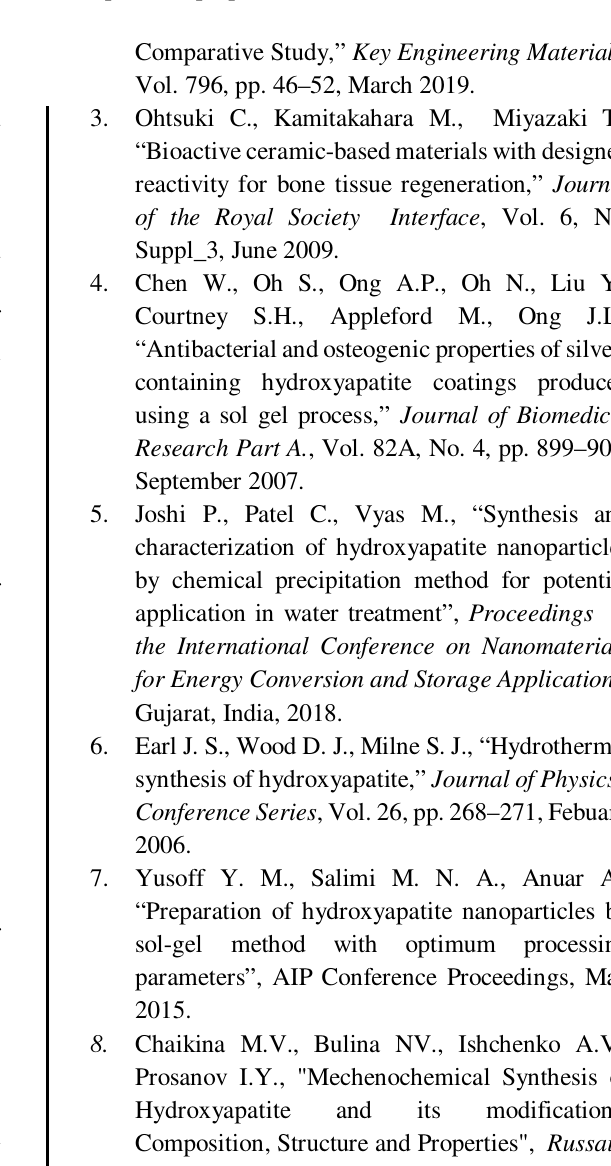
Fig. 5: Shows the anti-bacterial response of prepared